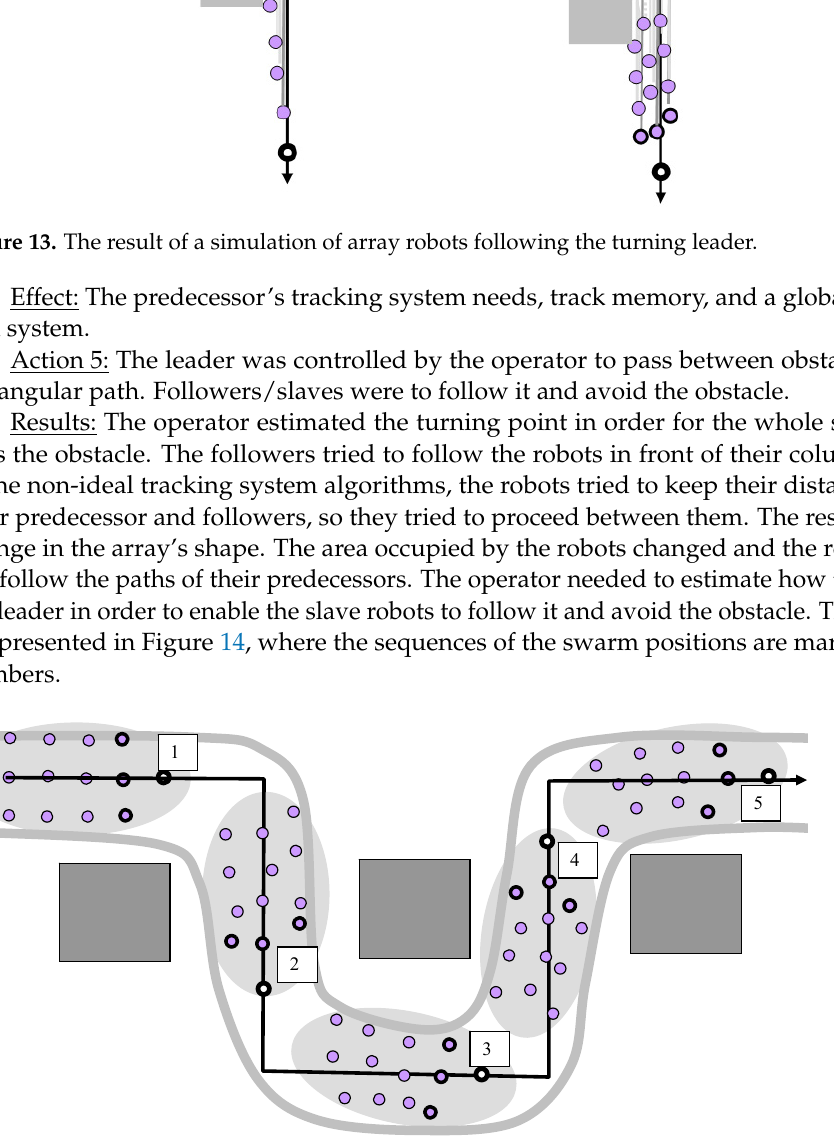
sequences of swarm positions are marked with Figure 14. The track of the swarm guided by an operator in test 5 for the array structure. The se- quences of swarm positions are marked with numbers.